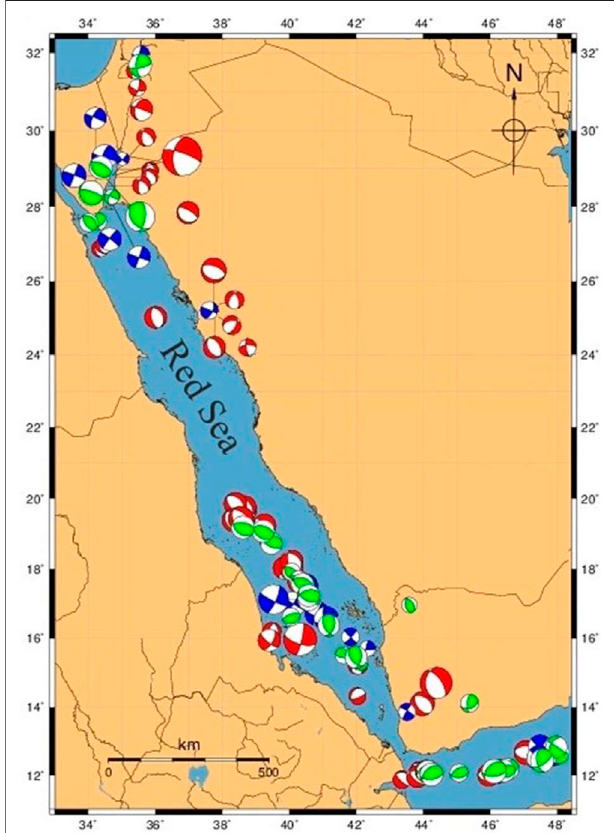
FIGURE 4 | Focal mechanism solutions of the 122 earthquakes in the Arabian Shield and its surrounding regions during the period from 1977 to 2021. Normal faulting solutions (in red). Strike-slip solutions (in blue) and thrusting solutions (in green). Size of focal sphere is proportional to